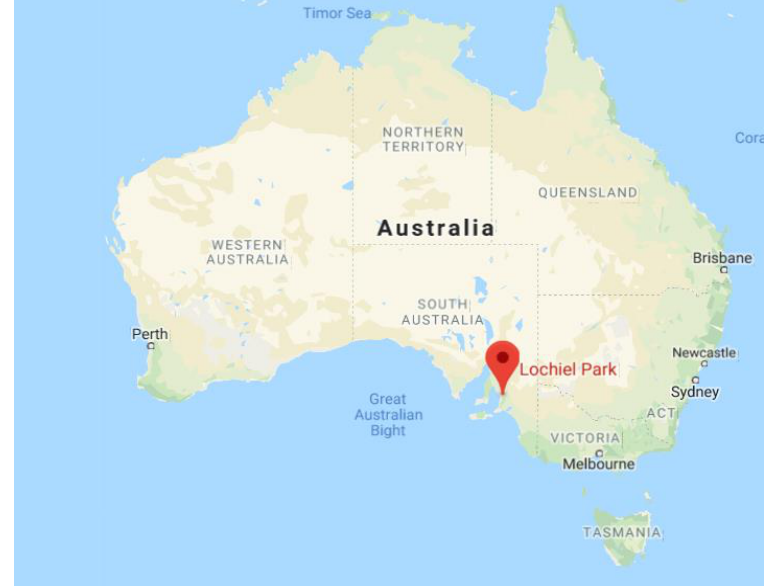
Figure 1. Lochiel Park, South Australia, Australia (Source: Google Maps Inc. [13]).